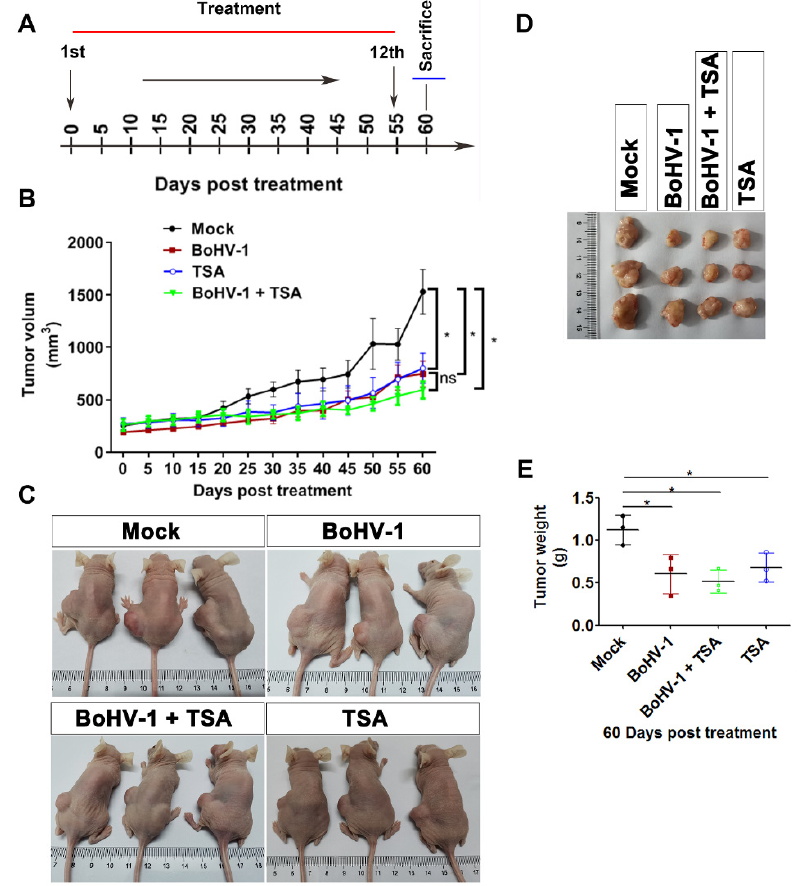
Figure 5. Oncolytic effects of BoHV-1 on human lung adenocarcinomas in A549 xenograft nude mouse model. ( A ) Diagram showing schedule of the treatment. A549 tumor bearing mice were either mock treated with PBS or treated with BoHV-1 (2 × 10 5 pfu/mouse) TSA (0.5 mg/kg), as well as BoHV-1 and TSA combination, from day 0 to day 55 with intervals of 5 days. At day 60 the mice were sacrificed to collect the tumor tissues. ( B ) Tumor volumes were measured from day 0 to day 60 with intervals of 5 days as indicated the diagram. Data shown in tumor growth curves are mean ± SD ( n = 3). Statistical difference at day 60 between each group was determined using Student’s t -test. * p < 0.05; ns, not significant. ( C ) Tumors in the mice were shown at the endpoint of the study. ( D ) Morphology of tumors removed from the mice at the endpoint of the study. ( E ) The volumes of tumors removed from the mice at day 60. Student’s t -test was employed to determine the differences between the two groups (* p <